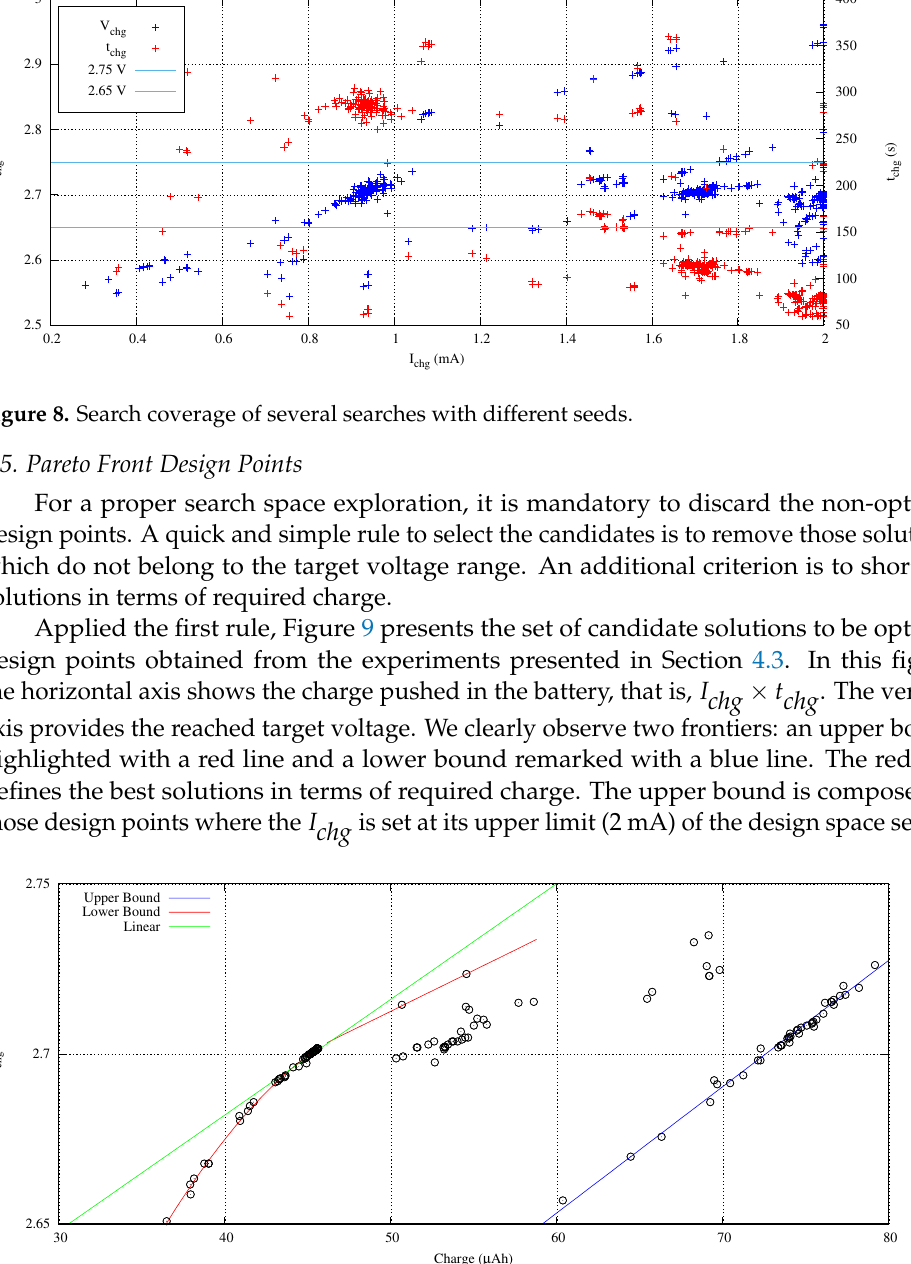
optimal design points ( I chg × t chg < 36.2 ± 0.1 µ